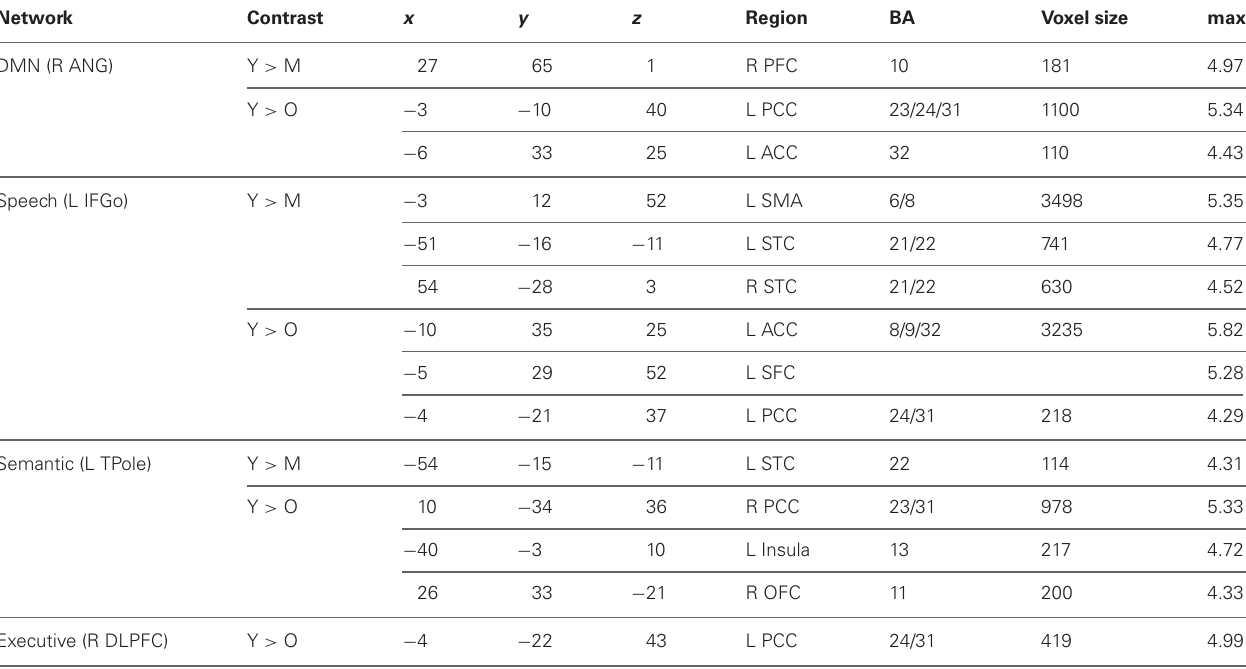
Table 2 | Contrast analysis of structural covariance network trajectories.